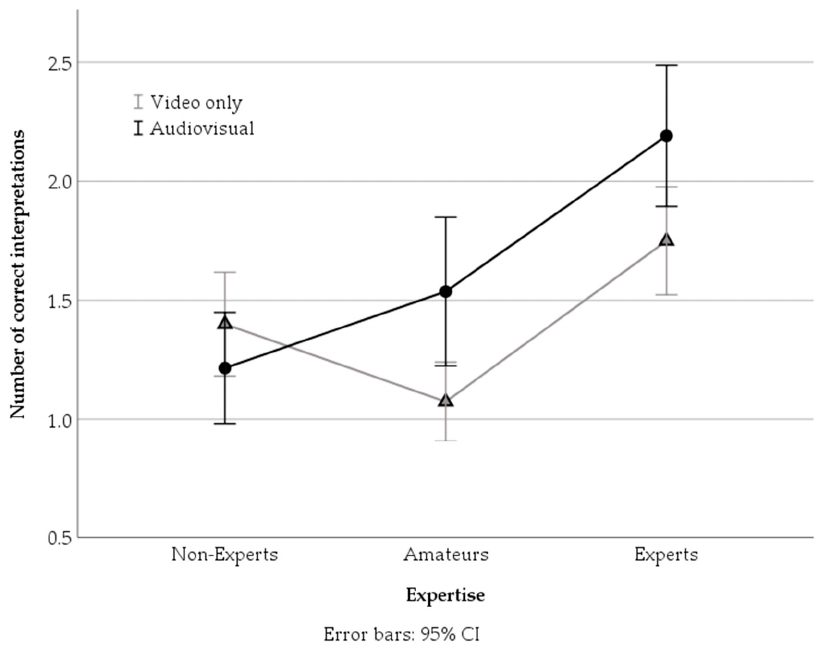
Figure 1. Correct interpretations as a function of expertise.